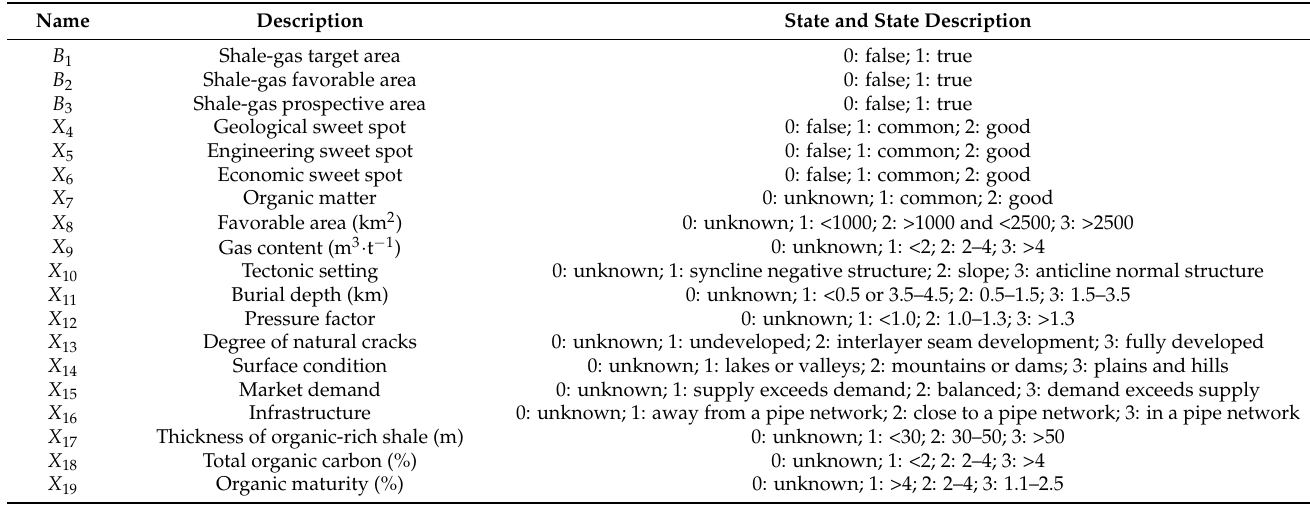
Table 3. Variables in the evaluation model of shale-gas sweet spots.